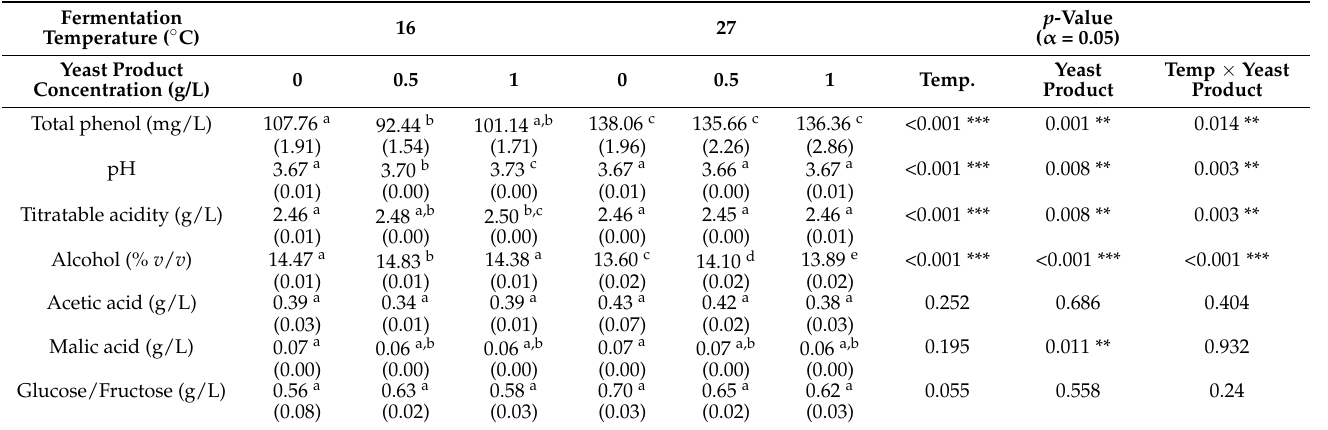
Table 2. Mean basic chemistry measurements of the wine treatments—mean ( ± SE) with factor and interaction significance from Tukey HSD. Letters refer to Tukey